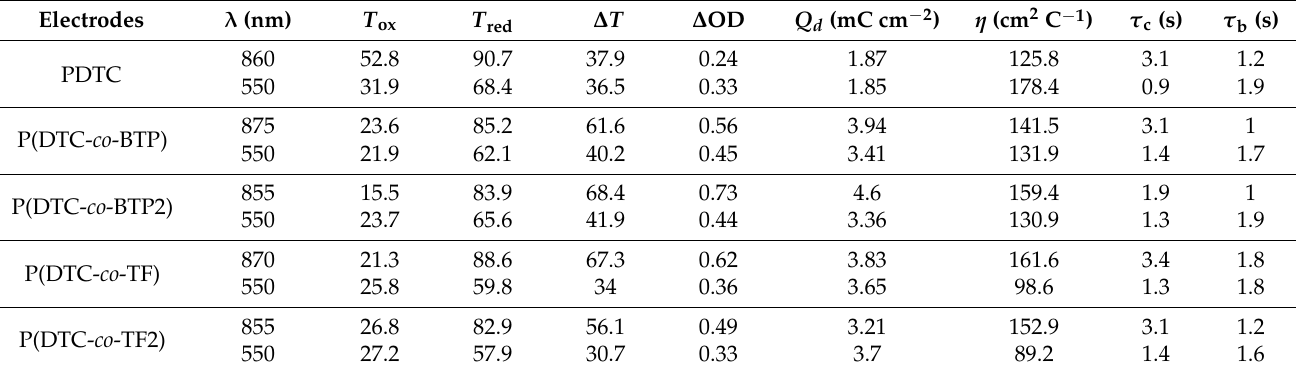
Table 3. Optical properties of electrodes.